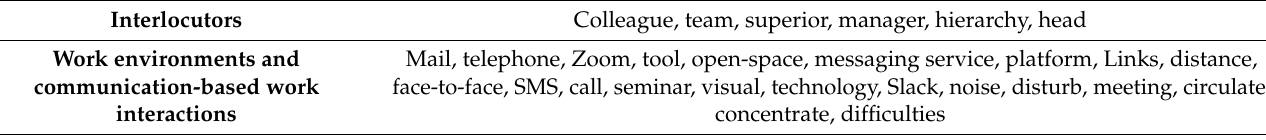
Table 4. Themes associated with the specific vocabulary of Class